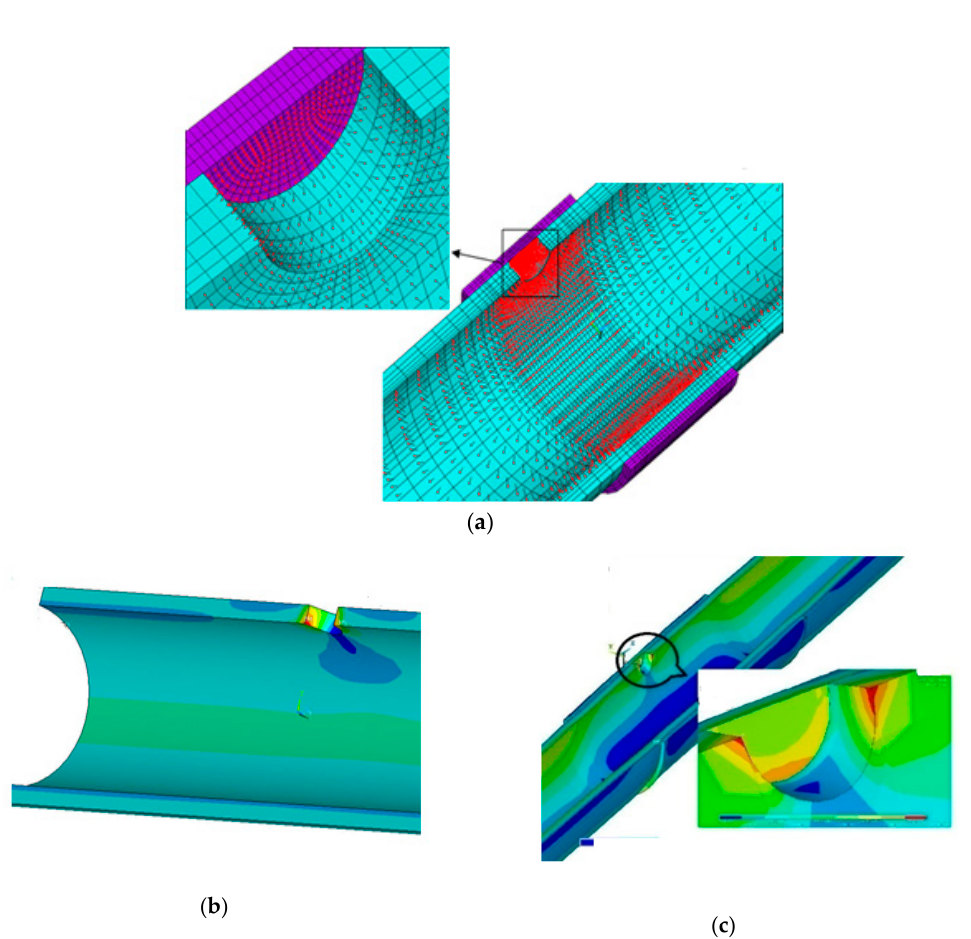
Figure 8. Finite element modeling of sectioned pipe and socket to show Von Mises stress distribution. ( a ) Mesh generation and the application of internal pressure. ( b ) Stress distribution in PE pipe with 1 ″ diameter circular hole. ( c ) Stress distribution in PE pipe and patch.